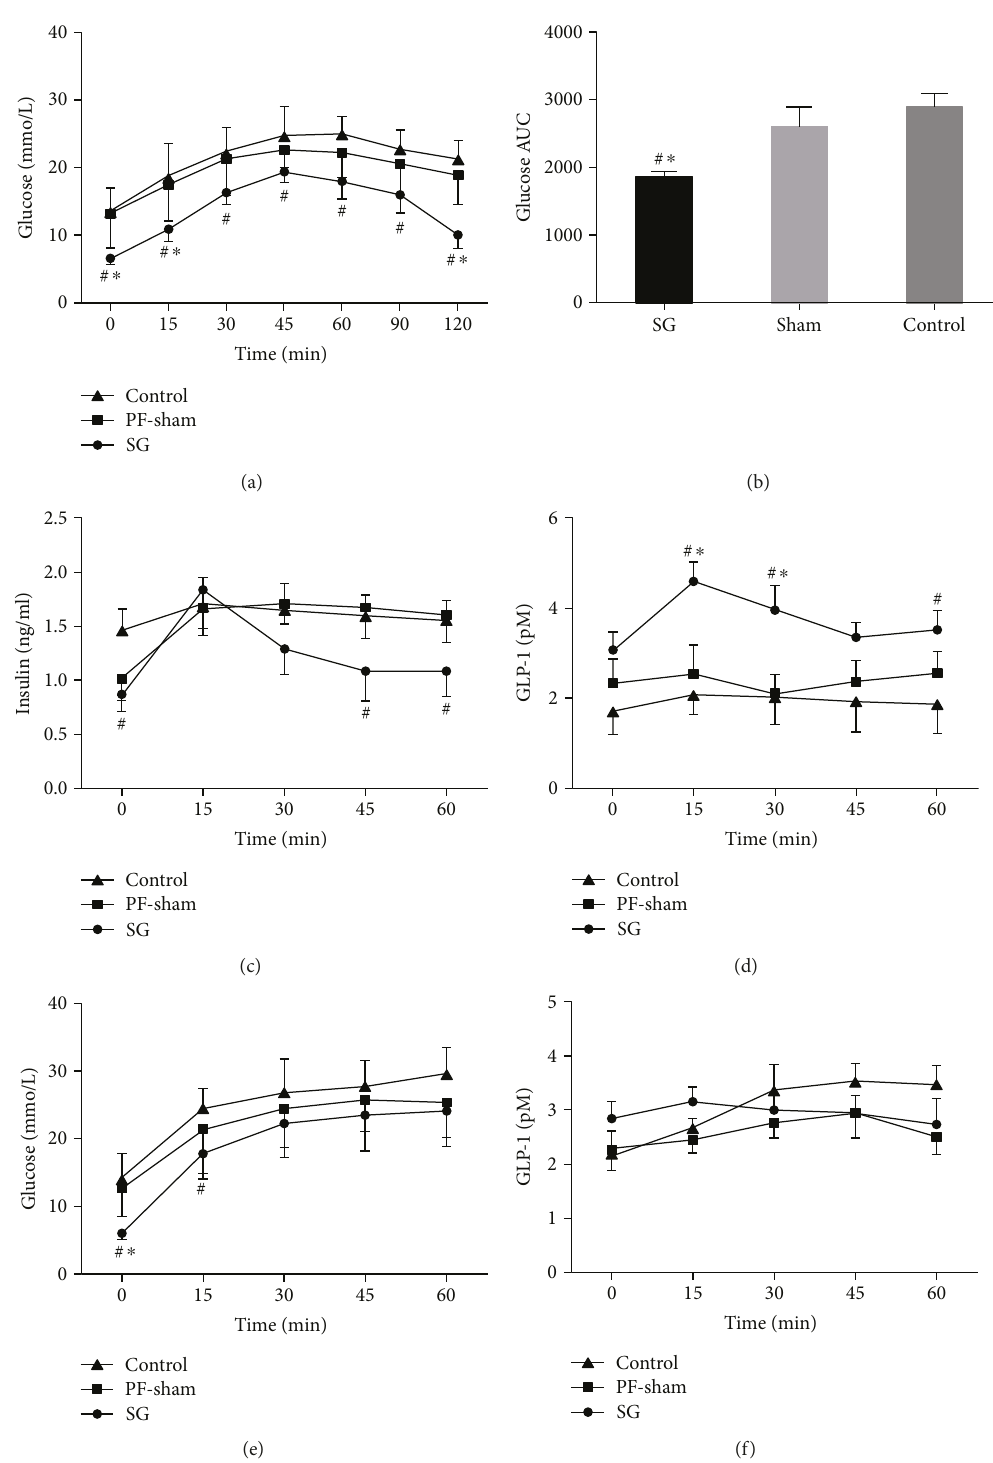
Figure 2: E ff ects of sleeve gastrectomy on glucose metabolism in GK rats. Line charts or bar graphs show the blood glucose (a), the AUC (b), insulin (c), and GLP-1 (d) in the oral glucose tolerance test, and blood glucose (e) and GLP-1 (f) after an IP injection of glucose. # P < 0 05 versus the controls; ∗ P < 0 05 versus